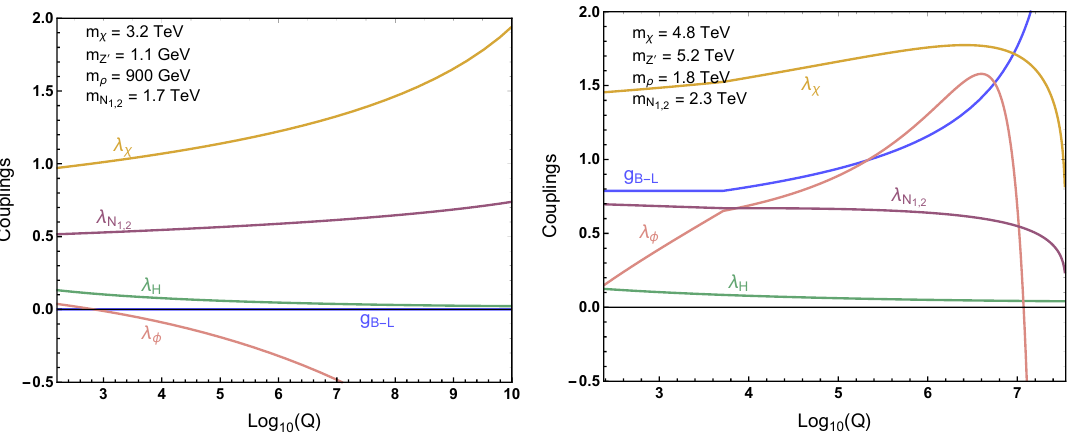
Figure 5 . Evolution of couplings for various choices of m (cid:31) , m Z 0 , m (cid:26) , and m N chosen to illustrate scalar instability (left) and the appearance of a Landau pole (right). The gauge coupling has been chosen so as to produce the correct relic